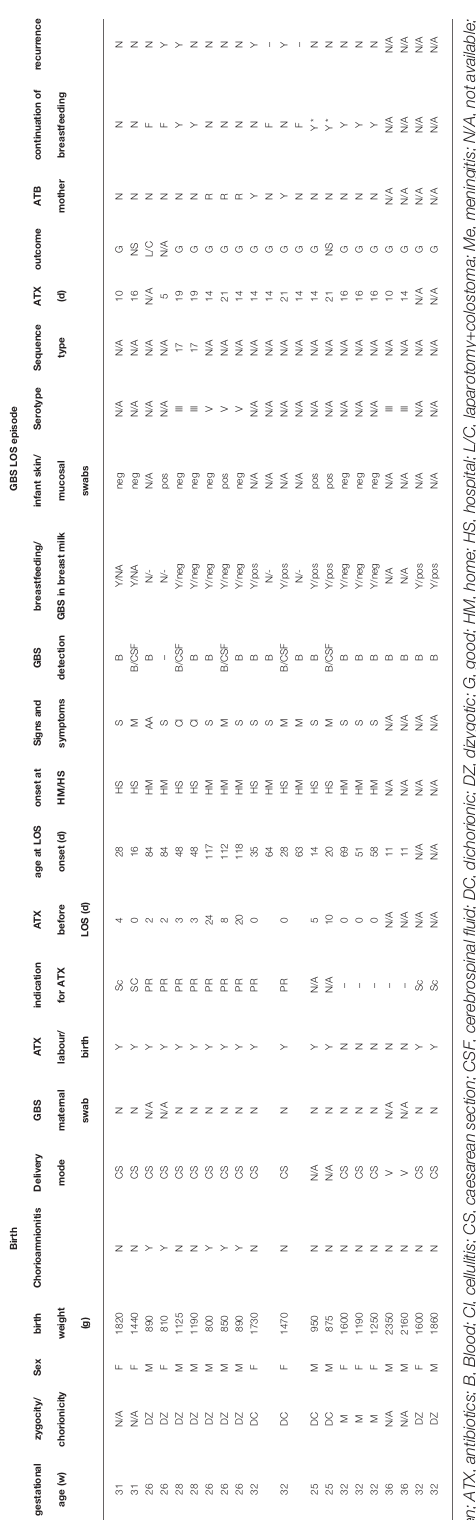
UKROI Cohort Demographic and Clinical Characteristics Twelve cases of recurrent iGBS were identi fi ed, accounting for 1.4% (12/856) of all infants with iGBS reported that year (20) ( Table 2 ). Eight (67%) infants were born prematurely, and fi ve (42%) infants were of very low birth weight (<1500 g). Ten (83%) infants were male and one (8%) infant was from a twin pregnancy. Median age at the onset of the fi rst iGBS episode was 11 (0- 73) days. Two (17%) infants had EOS and 10 (83%) LOS as the fi rst iGBS episode. Blood culture was positive in all cases. In two (17%) infants GBS was additionally identi fi ed in the CSF. The median duration of antibiotic therapy for the fi rst episode was seven (5- 14) days. Recurrence of iGBS occurred at a median age of 39.5 (23- 84) days. The interval from completion of initial therapy to onset of the second episode was 13 (5-75) days. In the second episode all infants had a positive blood culture and fi ve (42%) had also a positive CSF for GBS. The median duration of antibiotic therapy for the second episode was 21 (14-42) days. GBS capsular serotyping was performed in 17 isolates from 11 (92%) cases. Serotype III was the most commonly isolated serotype (n=7, 64%), followed by Ia, Ib and V, each identi fi ed in one (9%) infant. In eight (67%) cases isolates from both episodes were available with identical serotypes in seven out of these eight cases (88%). MLST sequencing was performed in 13 isolates from seven (58%) cases and identi fi ed ST-17 in four (57%) cases. Risk Factors for GBS Recurrence A univariable logistic regression showed that VLBW [OR 6.8 (1.9-22.0), P = 0.001], preterm birth [OR 5.6 (1.7-21.4), P = 0.005], a short course of antibiotics [OR 3.2 (1.0-10.9), P = 0.04] and male sex [OR 4.4 (1.1-28.7), P = 0.05] were associated with increased risk of GBS recurrence ( Table 3 , Table S2 ). When the categorical predictor variables were modelled together in a T A